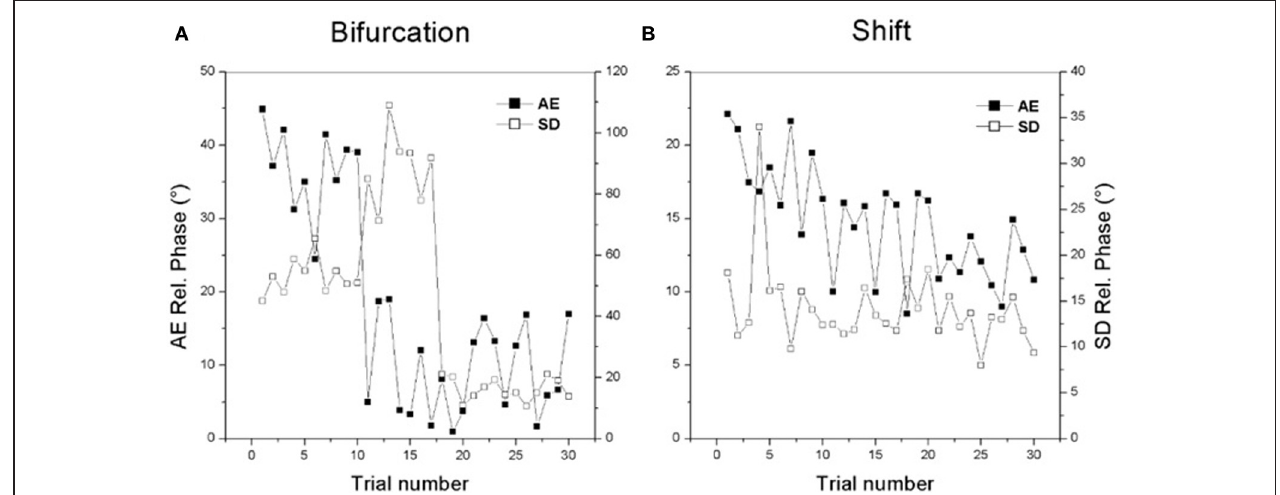
FIGURE 2 | Changes in individual performance for the two routes to learning. See text for details. (Data adapted from Kostrubiec et al.,